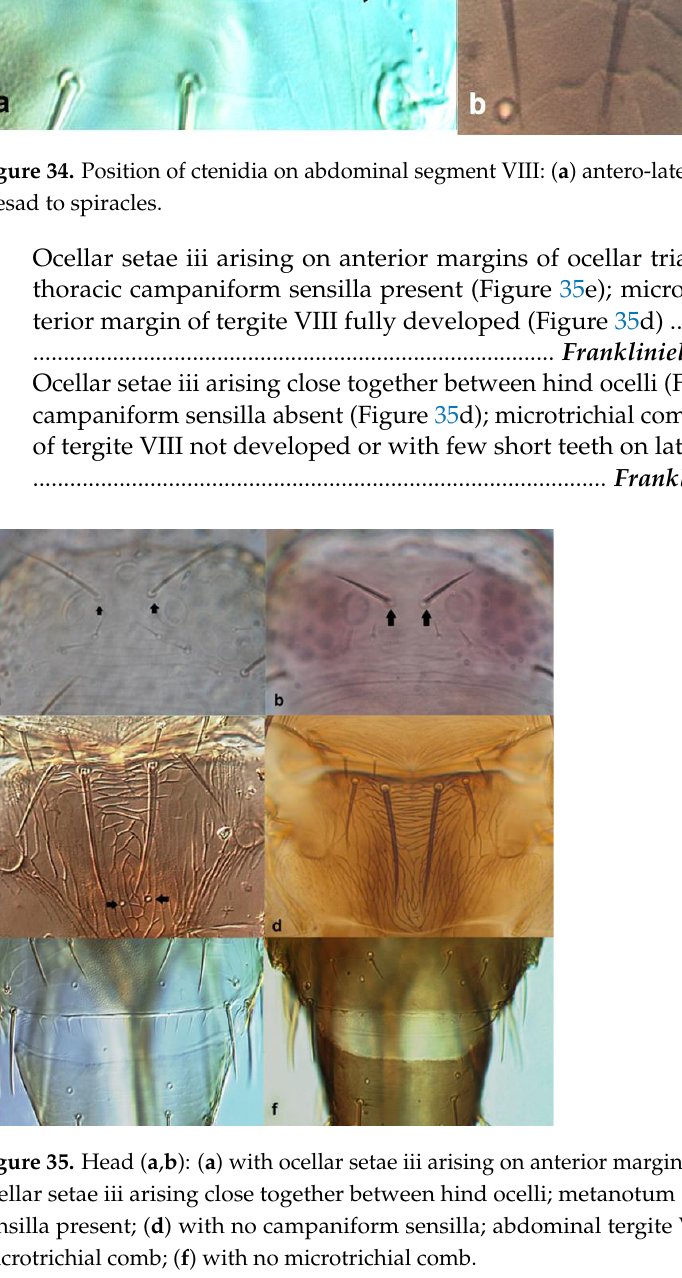
38 Abdominal tergite II with four lateral setae (Figure 36a); fore wing clavus with six marginal setae (Figure 32a) ………………………………… .. Thrips australis (Bagnall) Abdominal tergite II with three lateral setae (Figure 36b); fore wing clavus with five marginal setae (Figure 32b) ……………………………………………………………… 39